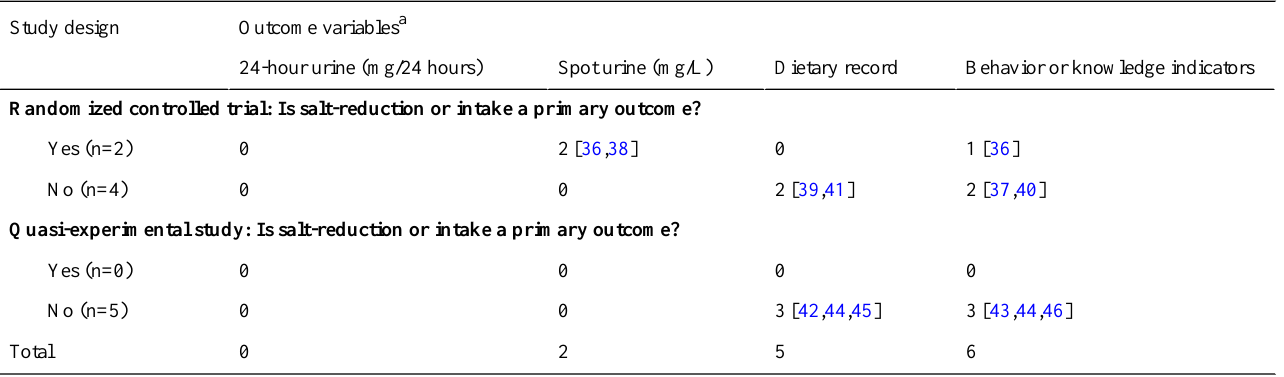
Table 3. Primary outcome and outcome variables employed by studies categorized by study design and if with successful salt reduction (n=11). Outcome variables a Study design